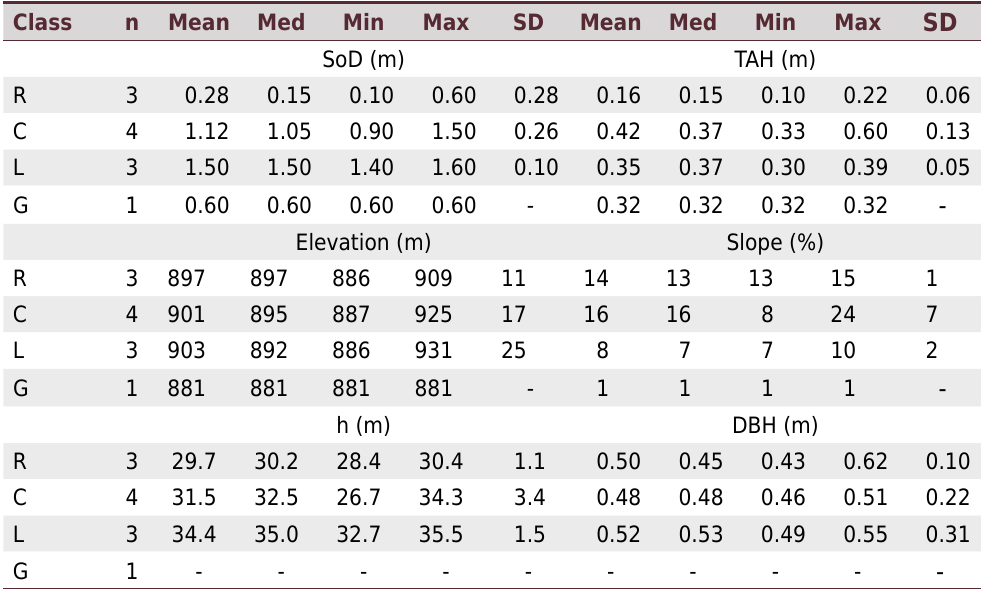
Table 3. Descriptive statistics of dendrometric, topographic, and morphological variables of soil dataset 1 separated by soil class Class